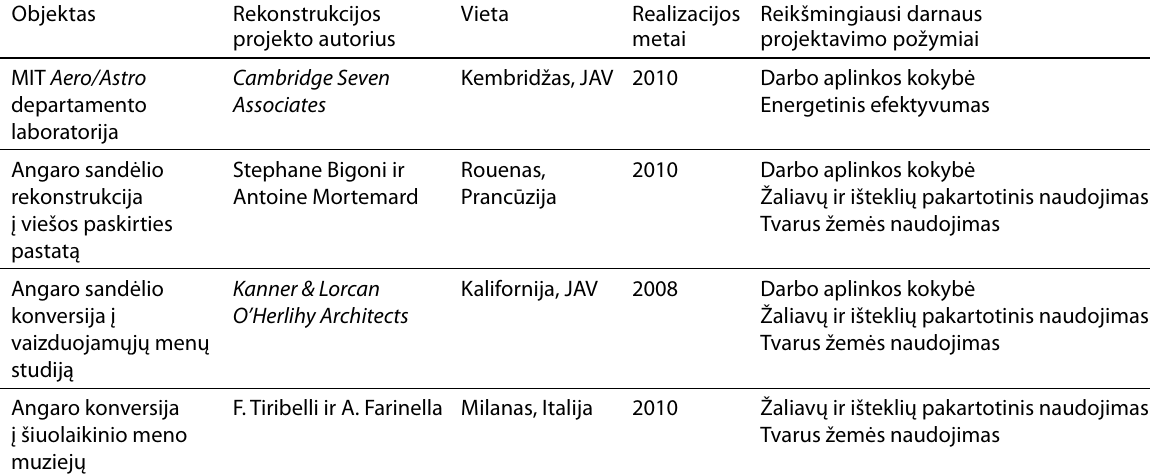
Table 2. a summary of characteristic hangar reconstruction projects objektas rekonstrukcijos projekto